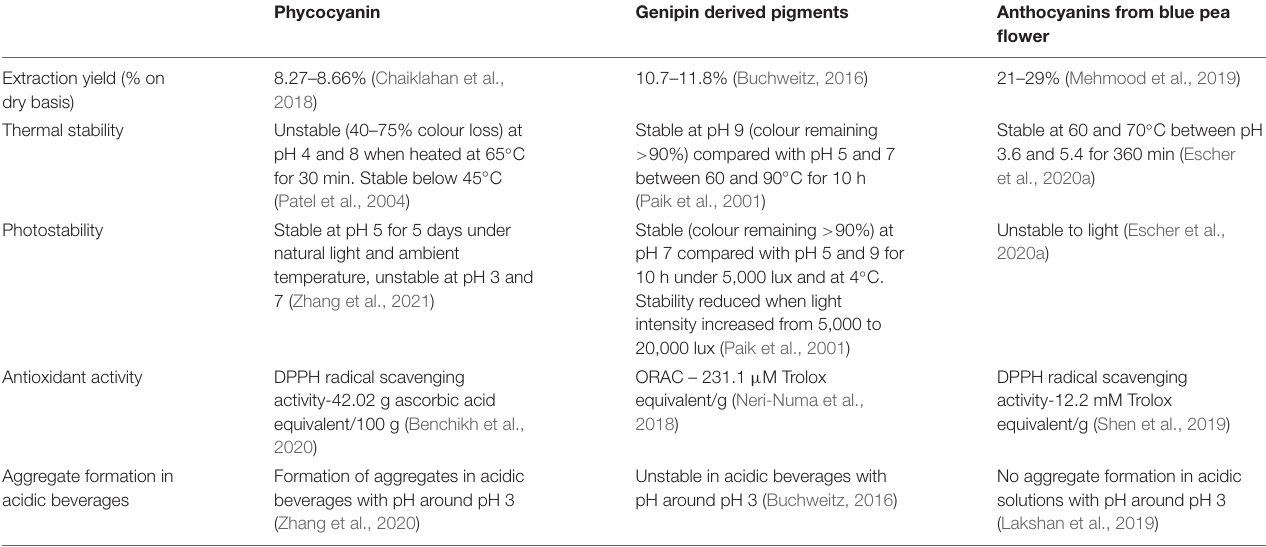
TABLE 2 | Comparison of common blue food colourants with anthocyanins from blue pea flower. Phycocyanin Genipin derived pigments Anthocyanins from blue pea